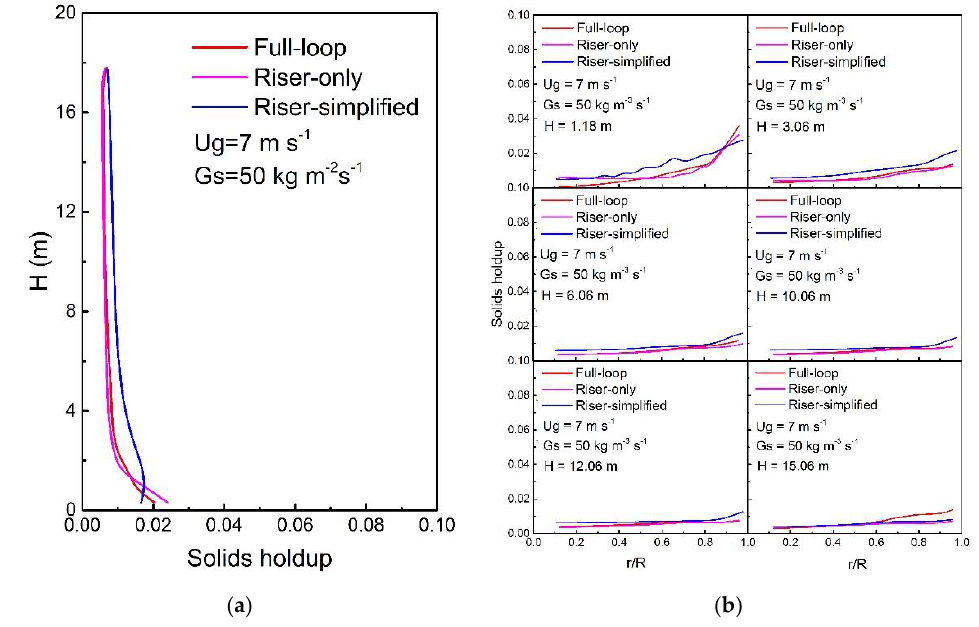
Figure 7. Comparison of solids holdup distribution in the CFB between different methods (U g = 7 m s − 1 , Gs = 50 kg m − 2 s − 1 ). ( a ) Axial solids holdup distribution, ( b ) radial solids holdup distribution.